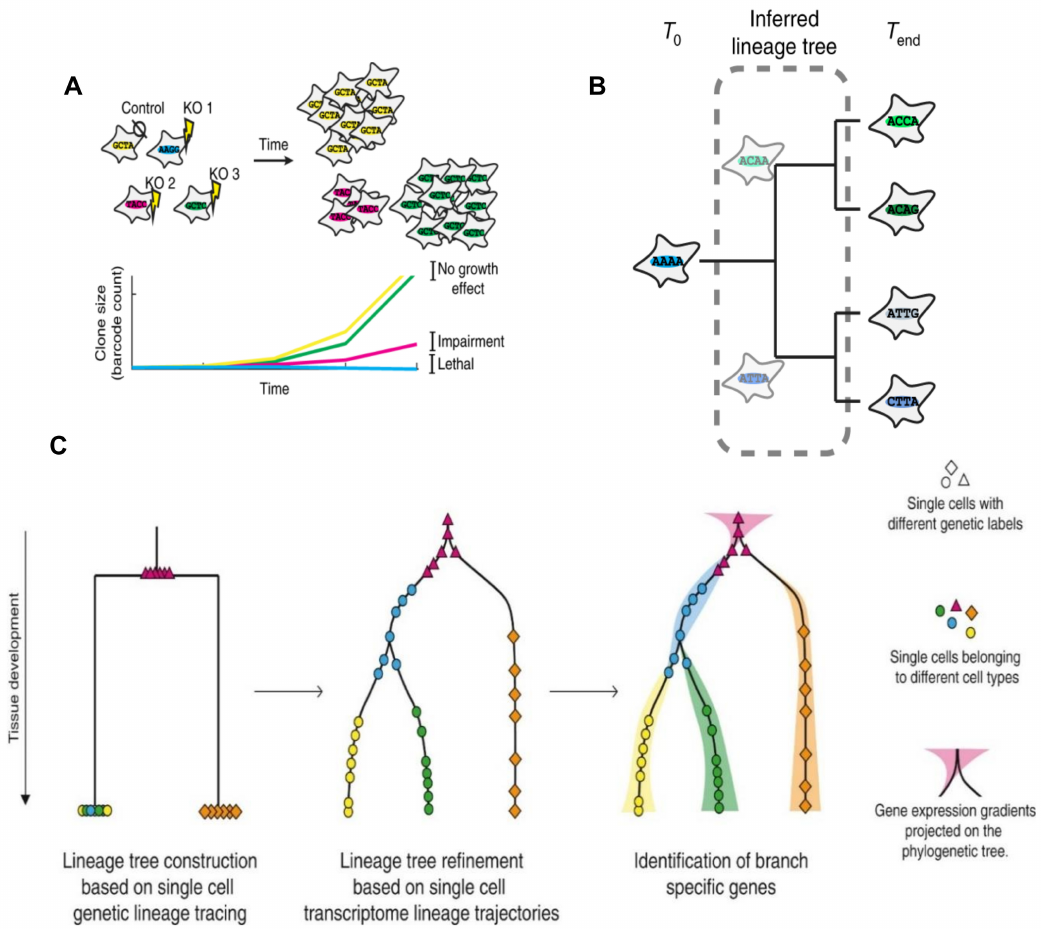
Figure 4. Application of cellular barcoding and lineage tree reconstruction based on single-cell lineage tracing and transcriptomics. ( A ) Cellular barcoding can be applied to cell fate mapping studies, such as to count the number of dividing stem cells in the stem cell niche to study the heterogeneity and clonality in breast tumors based on the number of labeled expanded lineages. ( B ) Evolving barcodes, such as those generated by CRISPR-Cas9 barcoding, allow the reconstruction of cell lineages in a single experiment through retrospective inference of cellular relationships on the basis of barcode similarity. Lineage relationships between cells at the experimental endpoint can be inferred from barcode similarity. ( C ) Lineage tree reconstruction based on the combination of single-cell genetic lineage tracing and single-cell transcriptomics. The first step is to construct a phylogenetic tree based on the genetic labels identified in single cells such as added DNA barcoding or CRSPR-Cas9 barcoding. Transcriptomics-based lineage reconstruction algorithms can then be used to refine this tree. Finally, gene expression gradients or patterns can be projected onto the phylogenetic tree to identify gene expression dynamics throughout the system. This figure is adopted from